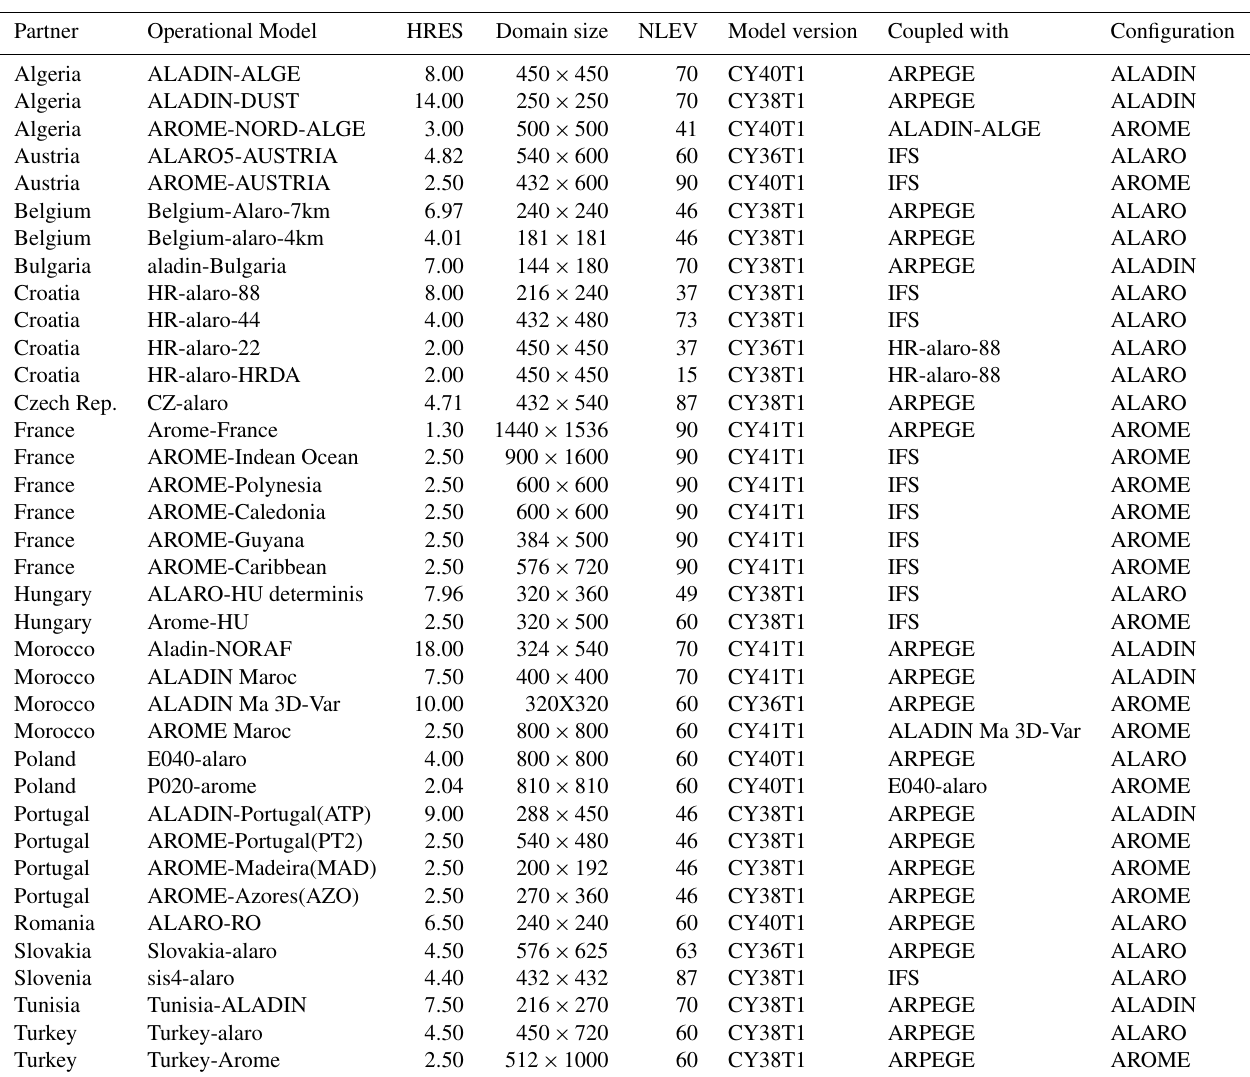
Table 5. The configurations of the ALADIN System running in the ALADIN partner countries (as in April 2017), with their nationally used name, horizontal resolution (HRES), domain size, number of vertical levels (NLEV), version of the ALADIN System, coupling model and the used configuration (ALADIN, ALARO,